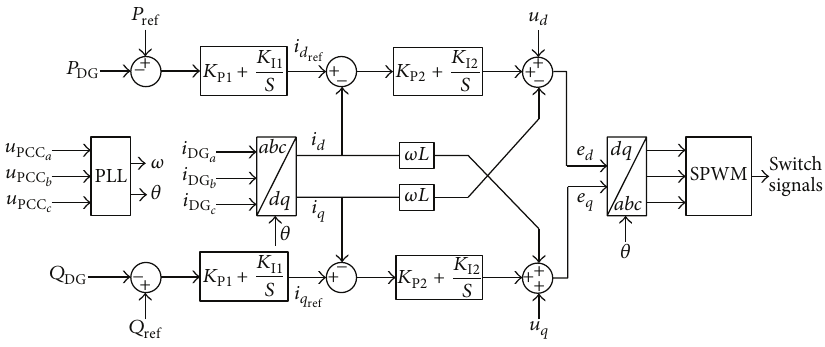
Figure 2: The block diagram of the DG interface